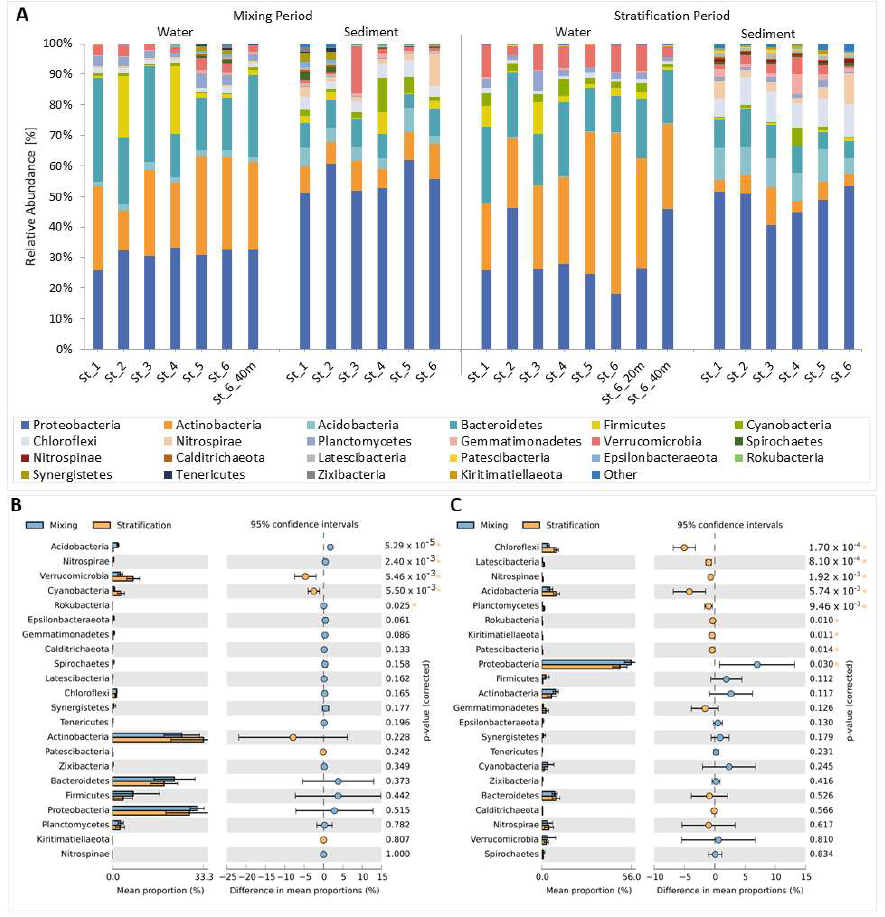
Figure 4. ( A ) The relative abundance of the main bacterial phyla during the mixing and stratification period of the lake (w: water, s: sediment), in which the taxa with a relative abundance <1% are merged and named as other. Differential analysis indicates the significant phyla during the mixing and stratification periods: ( B ) comparison of the water samples; ( C ) comparison of the sediment samples at the confidence interval of 95% ( p -value < 0.05) (* indicates significant difference). Proteobacteria represented 26–33% of all bacterial communities of the surface water during the mixing period, and the relative abundances ranged between 18% and 46% during the stratification period. Whereas the relative abundance showed similarity between the surface water and bottom water layers during the mixing period (33%), a significant gradual increase throughout the water column was observed during the stratification period (18%, 26%, and 46% in the surface water, 20 m, and 40 m, respectively). In general, higher abundances of Bacteroidetes were observed during the mixing period compared to the stratification period. While the greatest Bacteroidetes abundances were recorded in the surface waters in site 1 (34%) and site 3 (32%), 27% of the total reads were assigned to Bacteriodetes species in the water samples taken from 40 m during mixing conditions. Actinobacteria represented 21–32% and 22–52% of all reads during the mixing and stratification period, respectively, and a decreasing trend in the abundance of Actinobacteria species was observed through the water column during the stratification period. Firmicutes members were generally not abundant in water samples. In all, 20% of the bacterial reads were assigned to Firmicutes in site 2 and site 4 during the mixing period. On the other hand, the highest percentage was observed in site 3 in the stratification period (10%). Cyanobacteria represented ≤ 1% of all reads during the mixing period; it reached 4% in site 1 and 6% in site 4 during the stratification. The members of Verrucomicrobia were enriched during